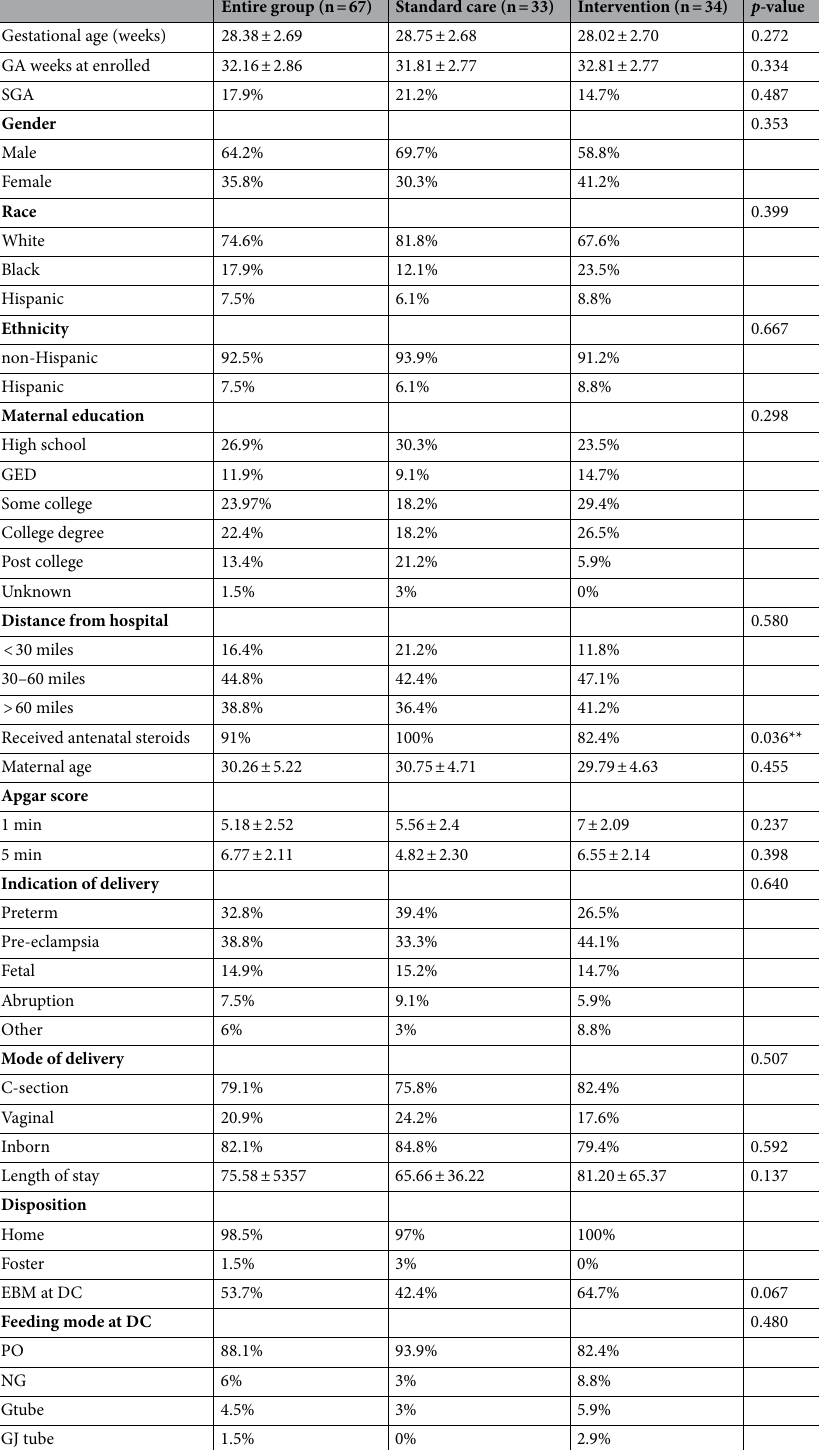
Table 1. Sample demographic and characteristics based on randomization. DC discharge, EBM expressed breast milk, GED general educational development, GA gestational age, SGA small for gestational age. *Mean ± standard deviation. ** p -value <